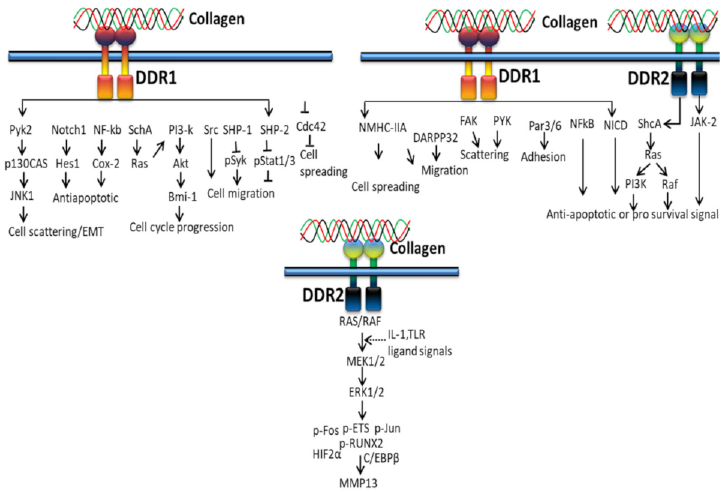
Figure 4. Collagen DDR signals in cell proliferation and survival.